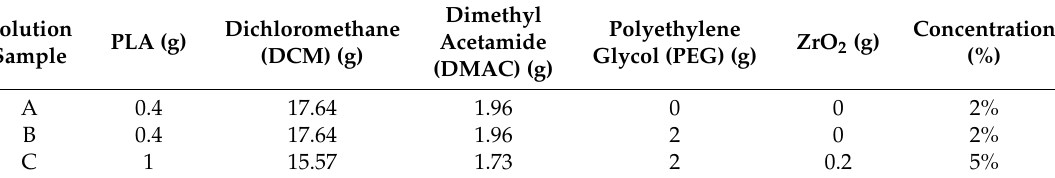
Table 1. Polylactic acid (PLA) solutions with different concentrations.